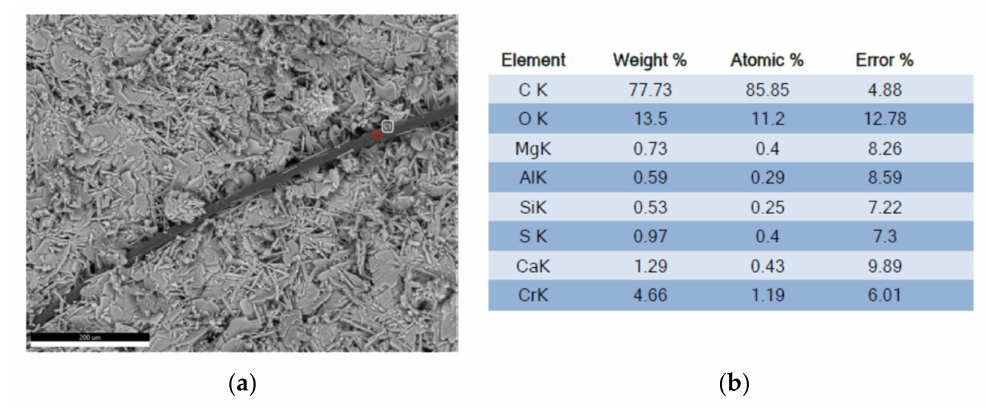
Figure 13. Analysis area and composition results ( a ) micrograph of calcium sulfate with additive with carbon fiber; ( b ) composition results of the area referred to carbon fiber. (Source: the author.)